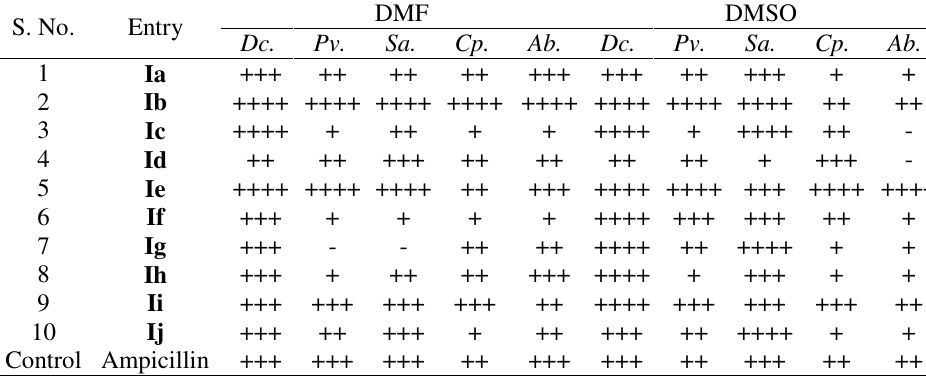
Table 3. Antibacterial activity of halo substituted Schiff